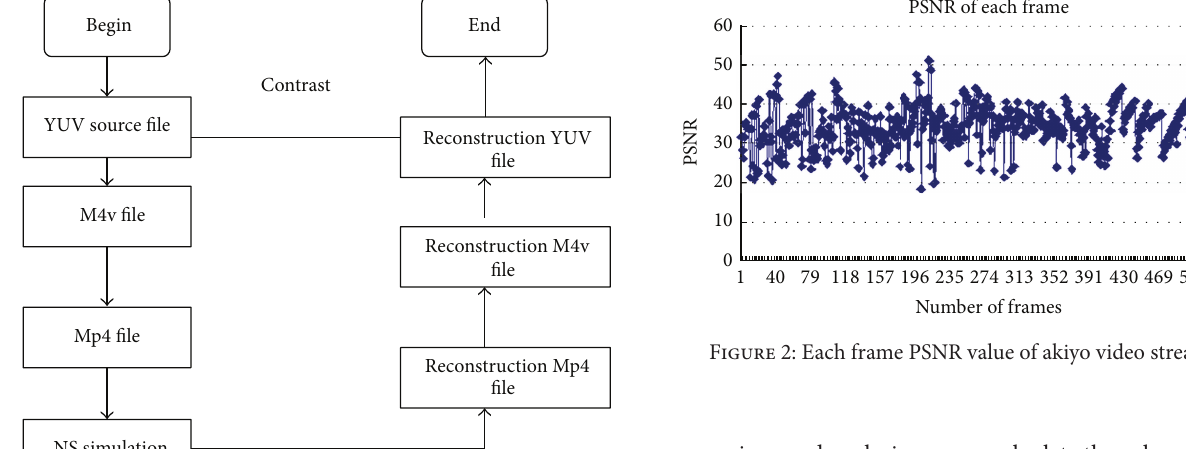
when the users watch video. The network transmission module is used to set up different QoS parameters and control network damage. Video quality evaluation module is used to compare the source video files and target video files to get user experience quality.